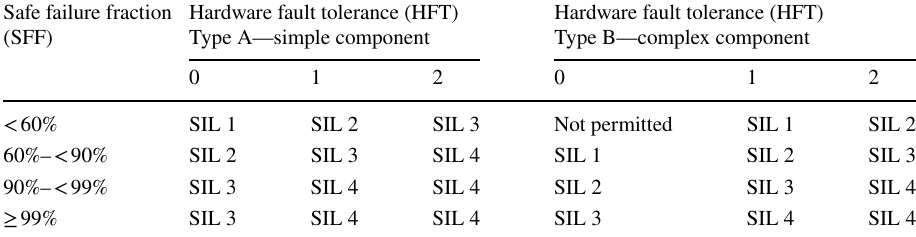
Table 5 Safety function configuration with respect to the architecture or voting arrangement of a particular SIF